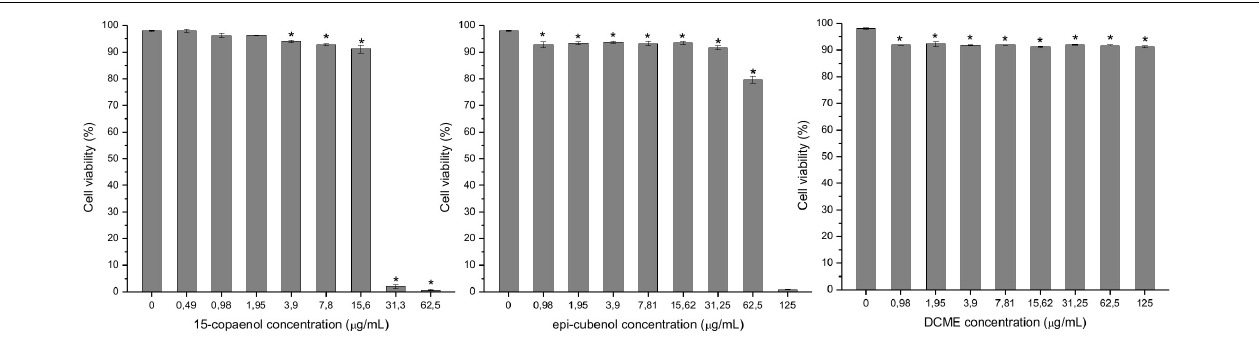
FIGURE 5 | Effects of 15-copaenol, epi -cubenol, and DCME extract on HeLa cell viability. The HeLa cells were incubated with different concentration of samples in a range of 125–0.5 µ g/mL. Results are the mean ± SE, n = 3. The asterisk indicates significantly different from the control at the same level ( P <